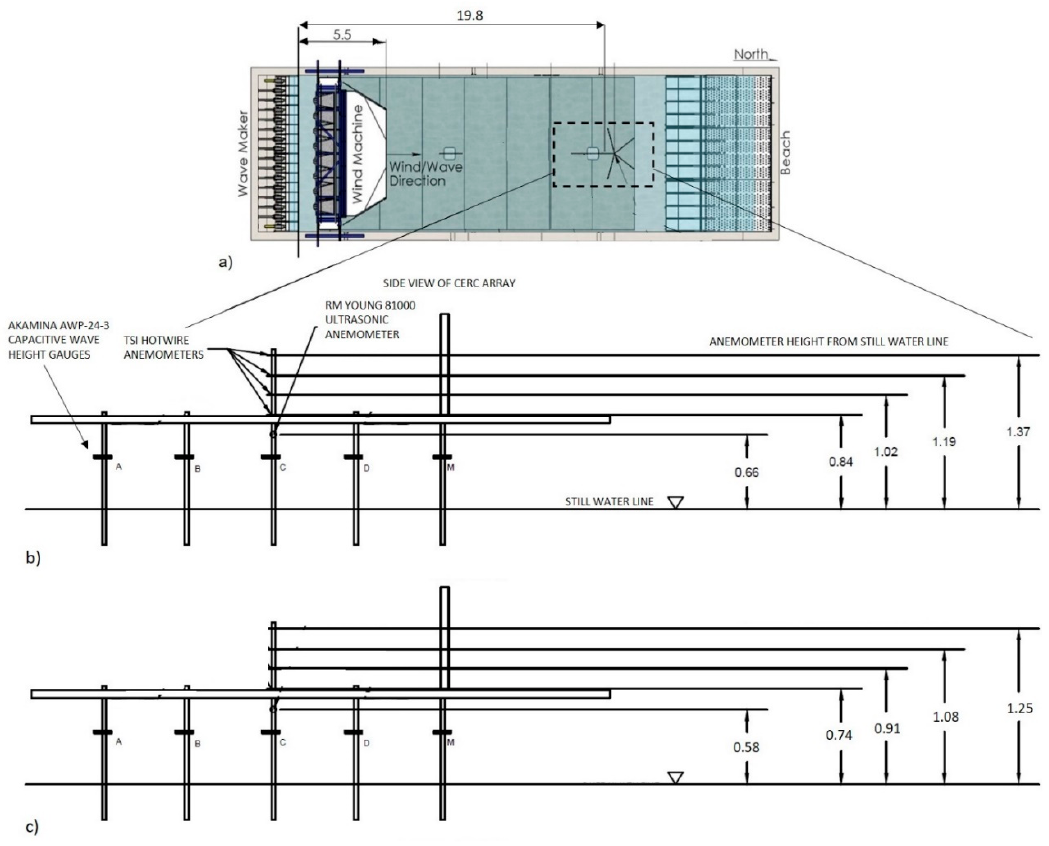
Figure 2. ( a ) Array position in the basin with respect to the wave maker and wind jet. The anemometer staff on the array is used as the horizontal reference for the array position to the wave maker. Dimensions shown are in meters. Side view of the instrumentation array with dimensions of ( b ) the first test campaign and ( c ) the second test campaign. Only center wave probes are displayed. Measurements shown are vertical distances from the mean water level to the anemometer locations. All dimensions are in meters.